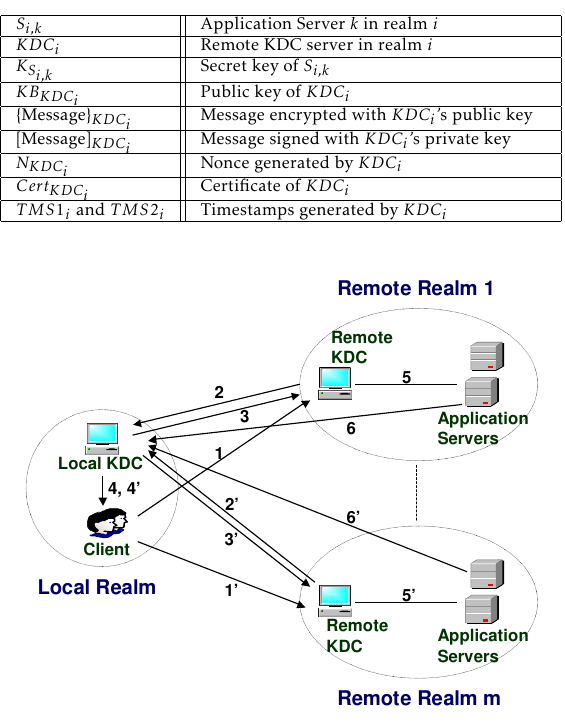
Figure 9. The Message Flow of The New Technique in Multiple Remote Realms